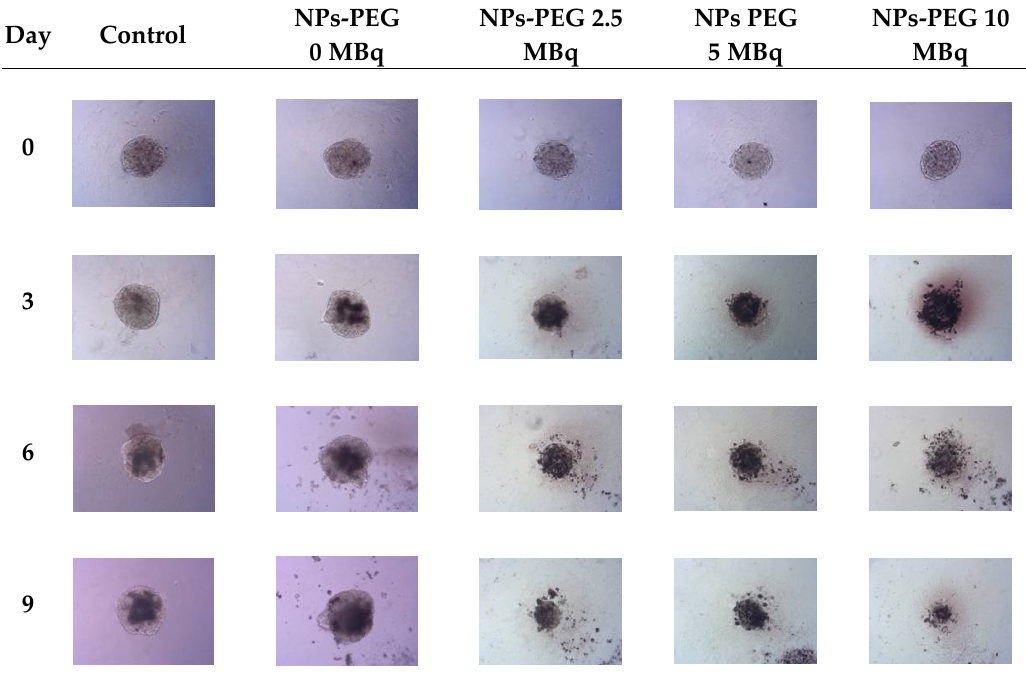
Figure 8. Microscope images of representative spheroids. Images made for spheroids incubated for 1 h with radioactive NPs-PEG on the day of treatment (Day 0) and on Days 3, 6 and 9 after treatment. Images were acquired with Primovert microscope equipped with Axiocam 105 color (Zeiss, Jena, Germany) with ZEN 2.3 lite software (Zeiss, Jena, Germany), 5× magnification.